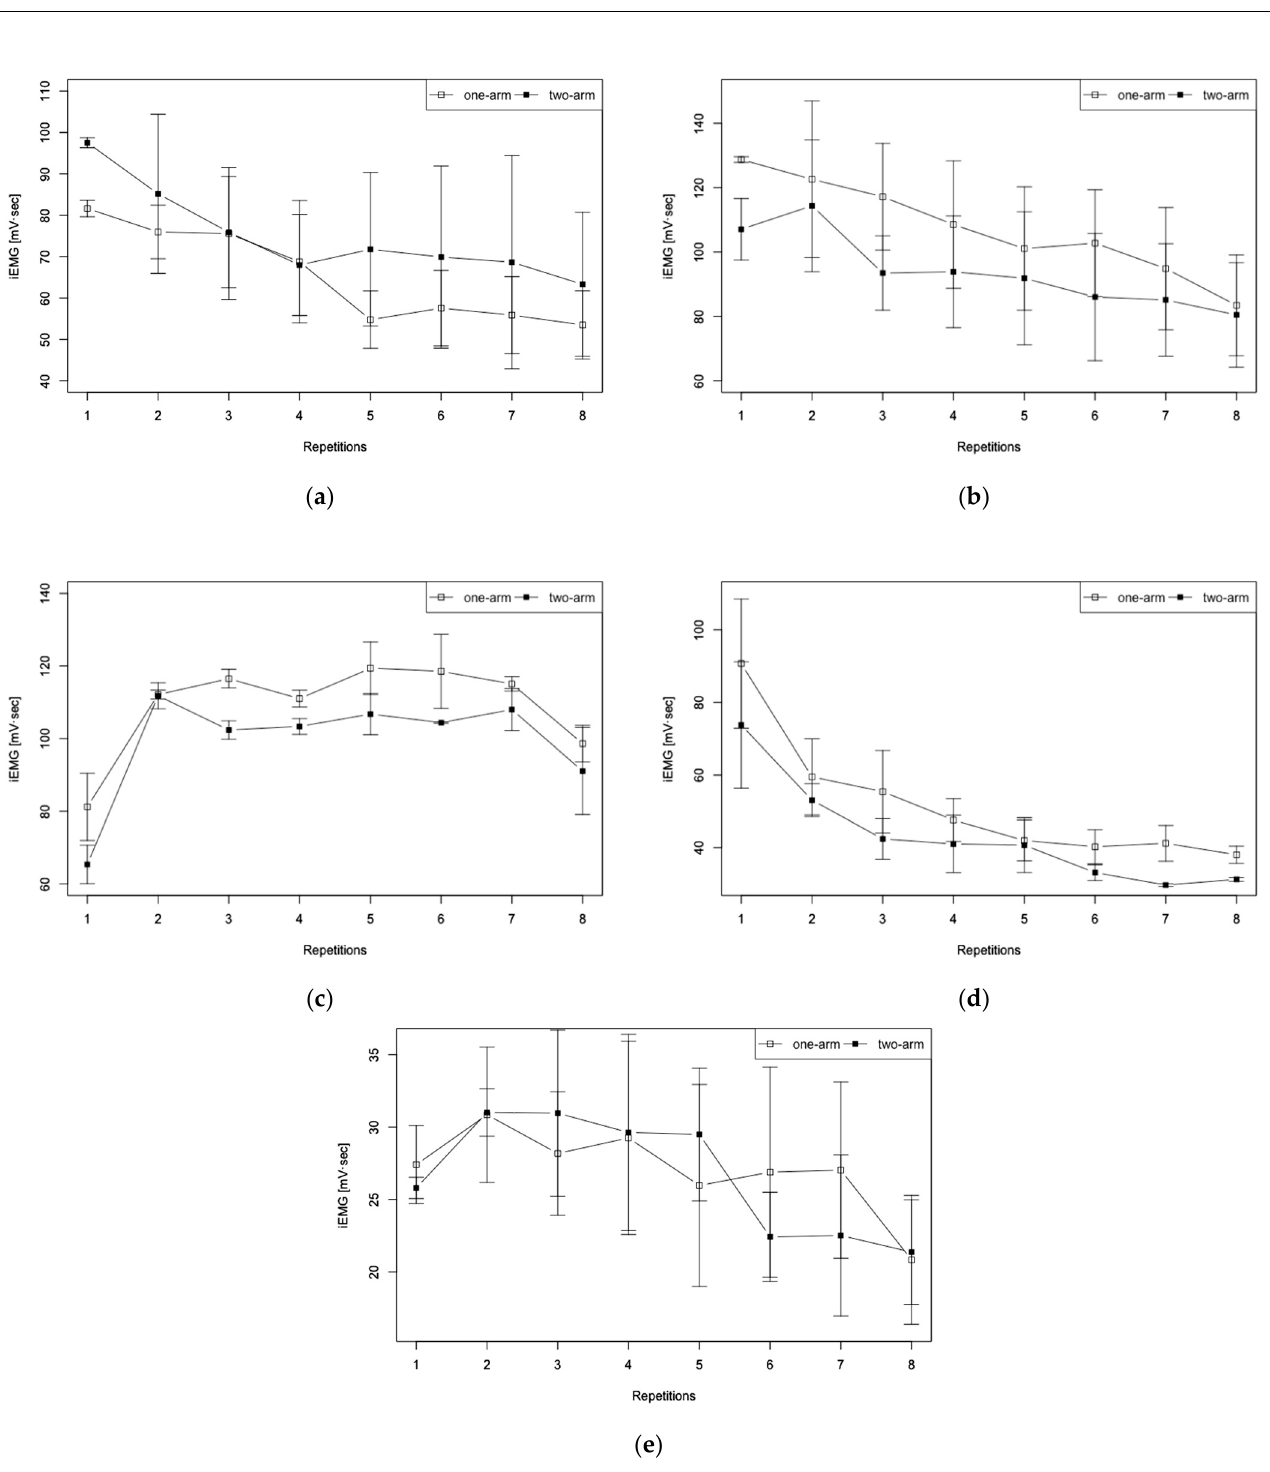
Figure 5. iEMG calculation results for eight strokes performed with one-arm and two-arm driving: ( a ) flexor digitorum profundus (pinky side), ( b ) triceps brachii, ( c ) deltoid, ( d ) pectoralis major, and ( e ) latissimus dorsi.